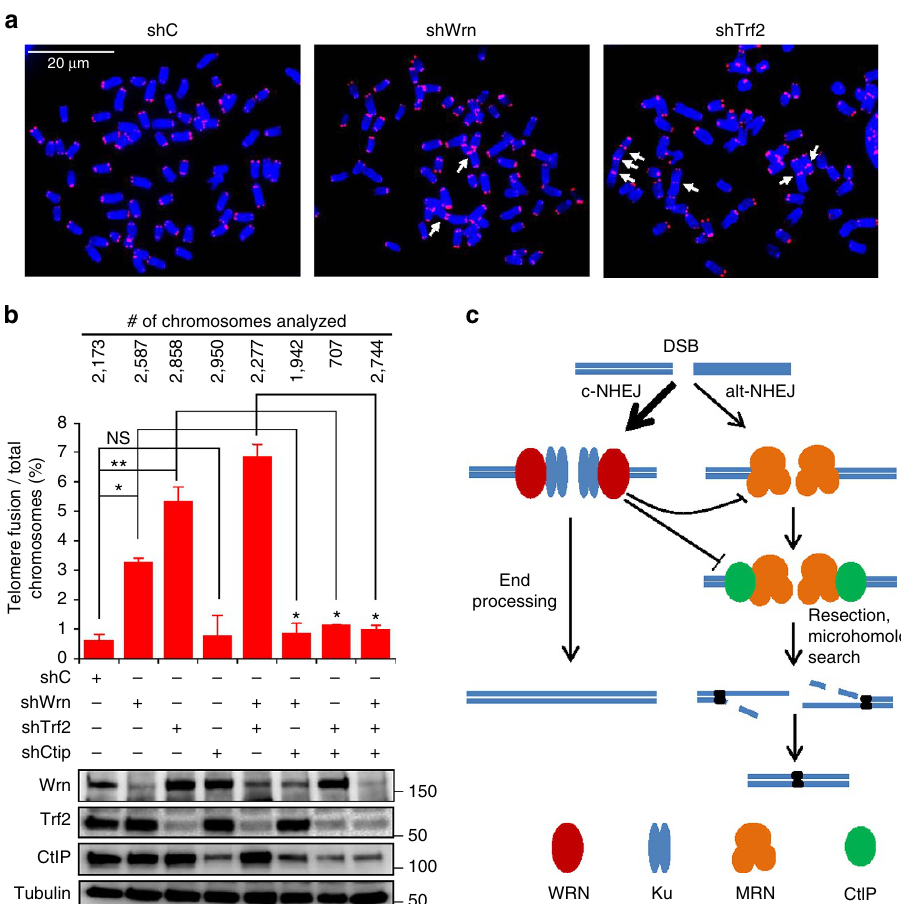
Figure 6 | CtIP mediates telomere fusions in WRN-deficient MEFs. ( a ) Metaphase chromosomes from MEFs infected with lentivirus carrying control, Wrn and Trf2 shRNA. Ten days post-puromycin selection, cells were arrested in mitosis with colcemid and telomeres were detected by hybridizing the chromosomes with Cy3-conjugated (TTAGGG) 3 probe (red). DNA was counterstained with DAPI (blue). White arrows indicate fused chromosomes. ( b ) Frequency of fused chromosomes in MEFs infected with lentivirus carrying shRNA. Mitotic chromosomes with telomere fusions were analysed and represented as per cent chromosomes with fused telomeres. Error bars represent standard deviation from two biological experiments. Immunoblots indicate expression levels of proteins in MEFs infected with lentivirus. ( c ) Cartoon showing WRN regulated c-NHEJ and alt-NHEJ. c-NHEJ is the major DSB pathway and is represented by thick arrow. WRN promotes c-NHEJ and inhibits alt-NHEJ by suppressing the recruitment and functions of MRE11 and CtIP. MRE11 and CtIP mediate DSB resection to promote alt-NHEJ, which results in large deletions and telomere fusions. Error bars indicate s.e.m. P value, *, o 0.05; **, o 0.01; NS, not